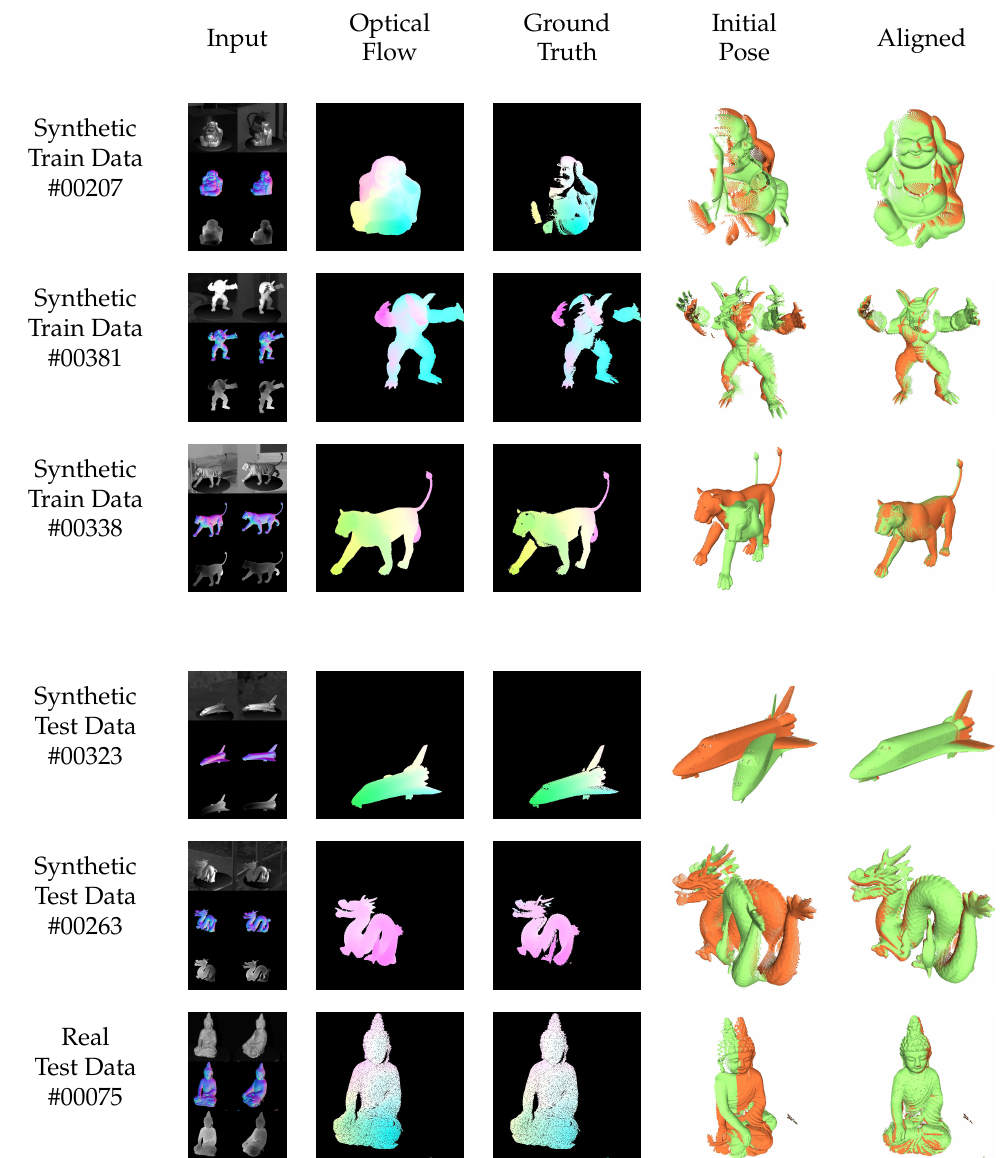
Figure 14. Qualitative results of the proposed method on training (top 3 rows) and test (bottom 3 rows) data of the synthetic inconsistent light dataset as well as real test data. The situation of inconsistent light represents the situation under investigation, motivating this paper, where the light sources or the objects in the scene move or rotate, yielding strong shading changes. The brightness assumption is dramatically violated. The network still generalizes well from known training to unknown test data. Even for real data without additional fine-tuning, the results are